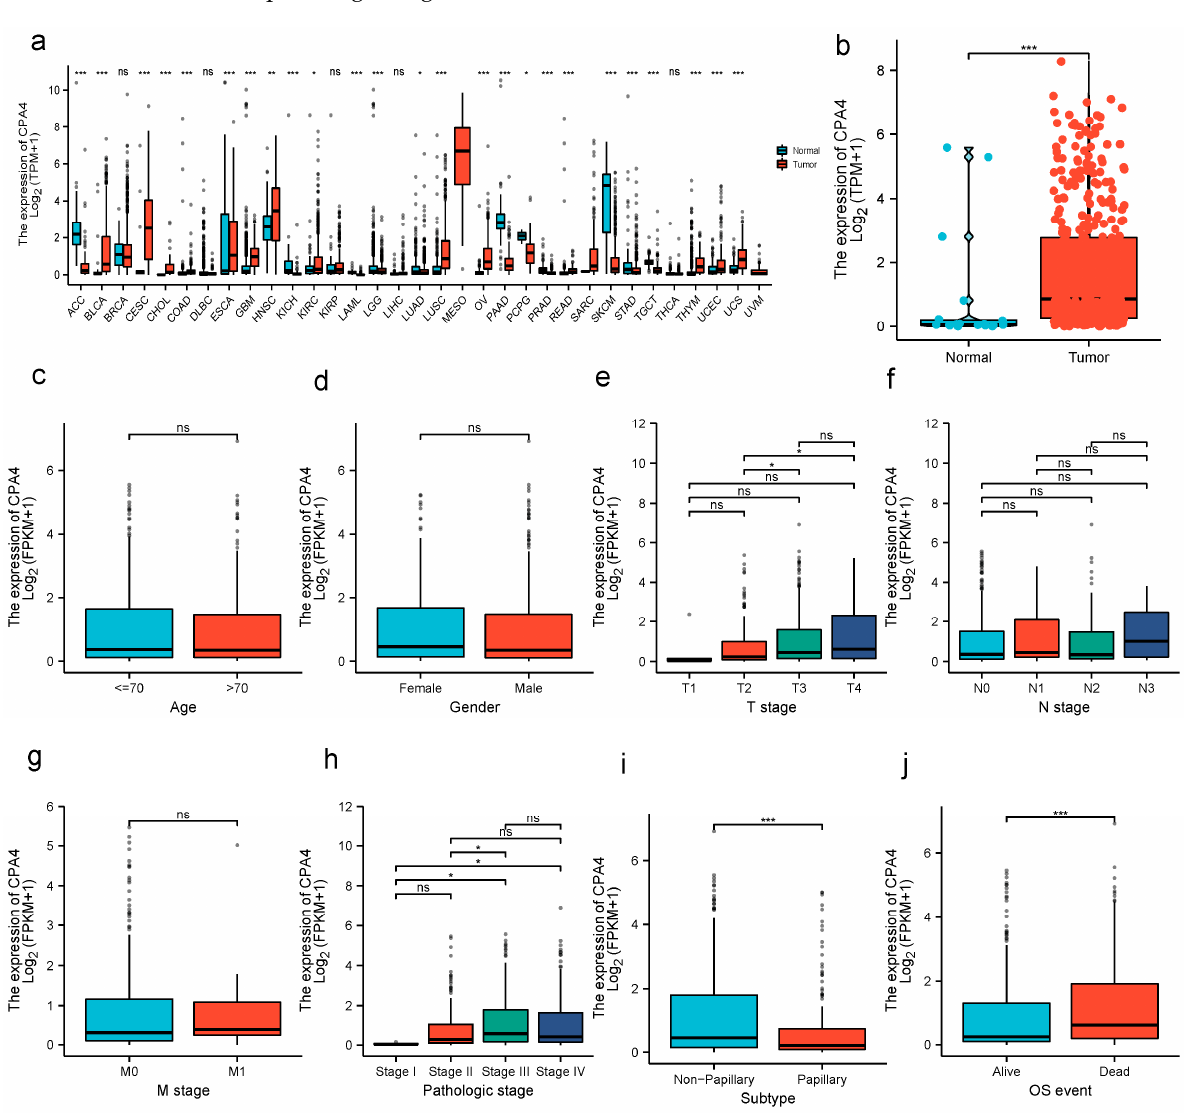
Figure 1. CPA4 expression and clinicopathological features in BLCA. ( a ) human CPA4 expression levels in different cancer tissues and corresponding normal tissues. ( b ) The expression level of CPA4 in BLCA tissue was significantly higher compared with the normal tissues from the TCGA + GTEx database. ( c – g ) No statistically significant differences were found between the expression levels of CPA4 in BLCA and age; gender; and pathological T, N, or M stage. ( h – j ) High pathologic stage, higher dead event, and nonpapillary were associated with higher expressions of CPA4 in BLCA. * p < 0.05; ** p < 0.01; *** p < 0.001; ns: no